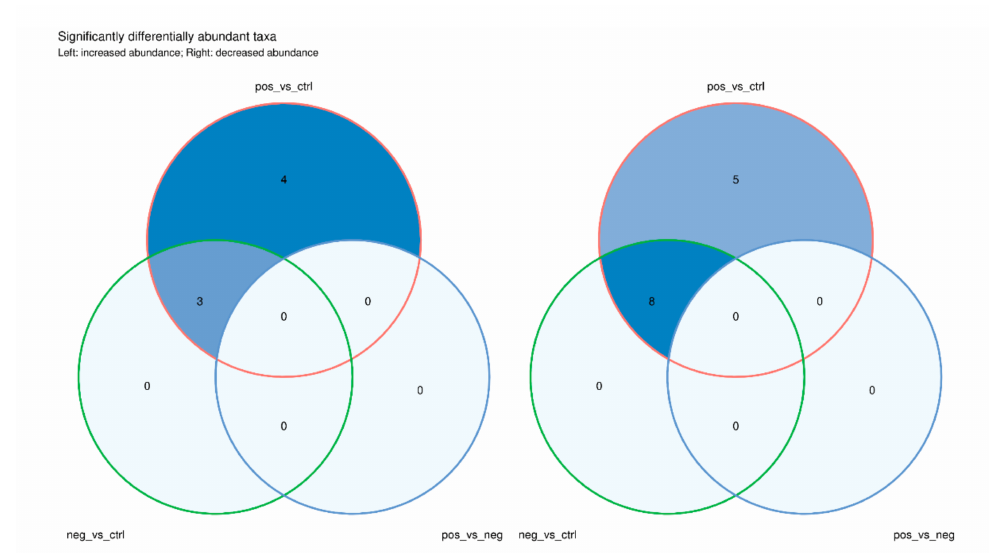
Figure 5. Common and unique genera among sample types. Venn diagram of differential abundance analysis performed between the CRE groups at the genus level. Genera found to be differentially abundant by at least one statistical test (Welch’s t or Wilcoxon test) are included. The analysis was performed on gene copy number-corrected values. An absolute ALDEx2 effect size > 1 and an adjusted p -value ≤ 0.05 were used as differential abundance